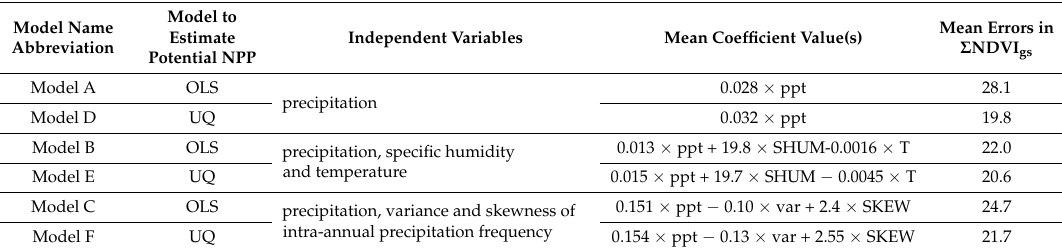
Figure 2. Potential Σ NDVI gs prediction errors: ( a ) errors of the OLS regression between Σ NDVI gs and precipitation (model A); Compared with model A are: ( b ) percentage reduction in potential Σ NDVI gs prediction errors of the OLS regression between Σ NDVI gs and precipitation, specific humidity, and temperature (model B); and ( c ) percentage reduction in potential Σ NDVI gs prediction errors of the OLS regression between Σ NDVI gs and precipitation, its seasonal distribution variance, and skewness (model C); ( d ) Frequency distribution of prediction errors for the three models normalized by the range of Σ NDVI gs values (prediction error/maximum Σ NDVI gs –minimum Σ NDVI gs ); and ( e ) frequency distribution of the values in ( b , c ). The red lines from north to south are the 300 mm, 700 mm and 1100 mm rainfall isohyets. Table 2. Independent variables used in OLS and UQ regression models to estimate potential Σ NDVI gs values. The mean regression coefficient values and potential Σ NDVI gs prediction errors at the 95% confidence level are the averages of all regression equations estimated for each 3 × 3-pixel grid cell. SHUM—specific humidity; OLS—ordinary least squares; UQ—upper quartile regression; SKEW—skewness of intra-annual, daily precipitation frequency; ppt—precipitation; T—air temperature.